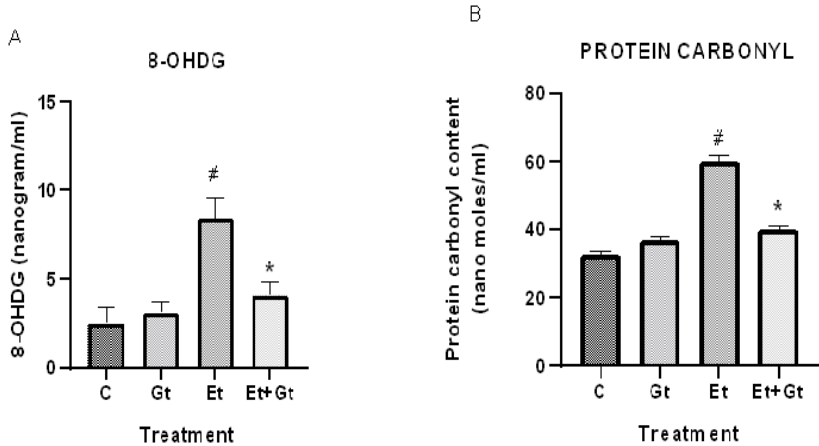
Figure 3. Gingerol treatment suppressed 8-OHDG ( A ) and protein carbonyls ( B ). Assessments were done in control (C), 6-gingerol (Gt)-, ethanol (Et)- and ethanol plus 6-gingerol (Et + Gt)-treated rats. The data were expressed as mean ± SD. # p < 0.05 compared with control and * p < 0.05 compared with ethanol-treated groups.